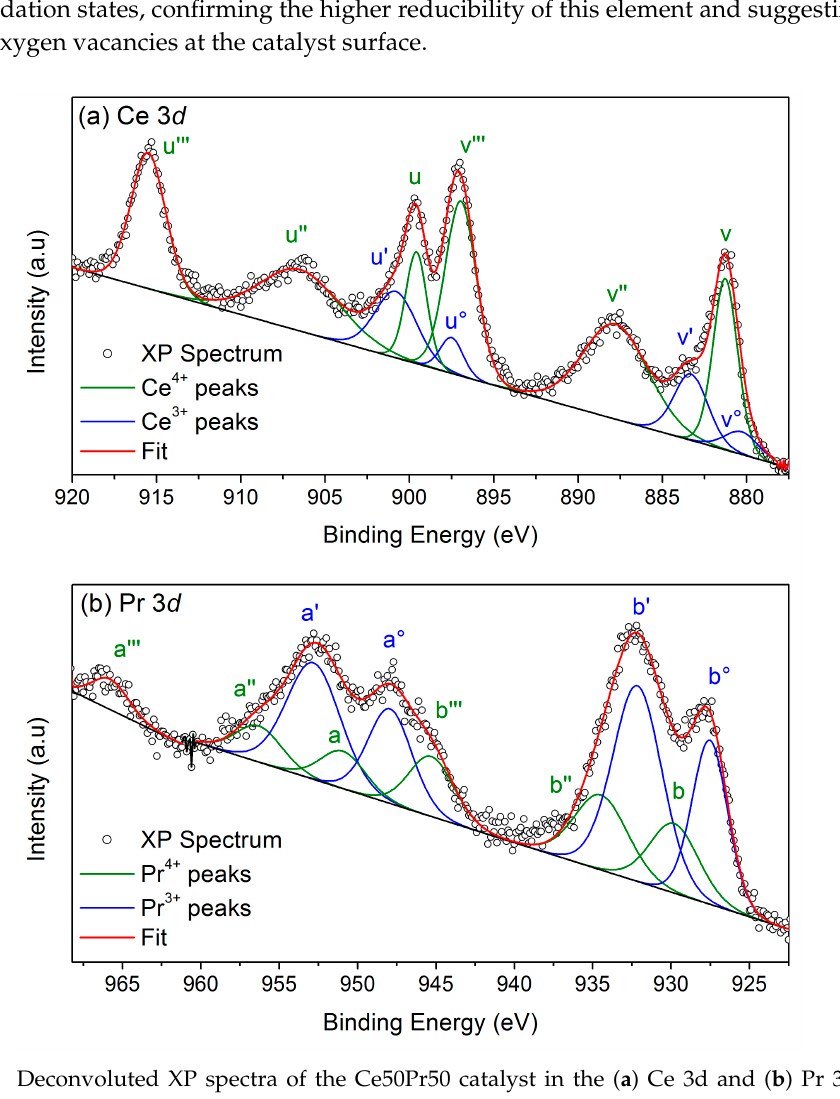
Table 1. Relative abundancies of different species on the surface of the Ce50Pr50 catalyst derived from the deconvolution of the XP spectra.